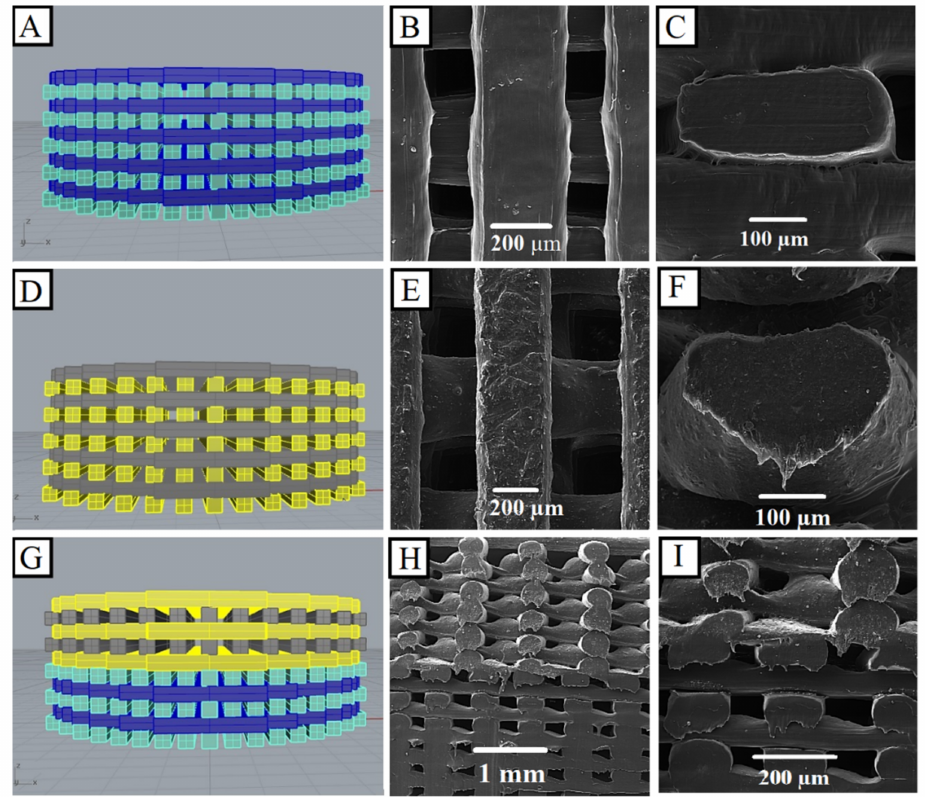
Figure 3. Morphological characterization of the 3D-printed PCL/BG, PCL/HyA, and bilayer scaffolds ( A , D , G ) CAD models of the scaffolds; ( B , E ) top view and ( C , F , H , I ) cross sectional FESEM